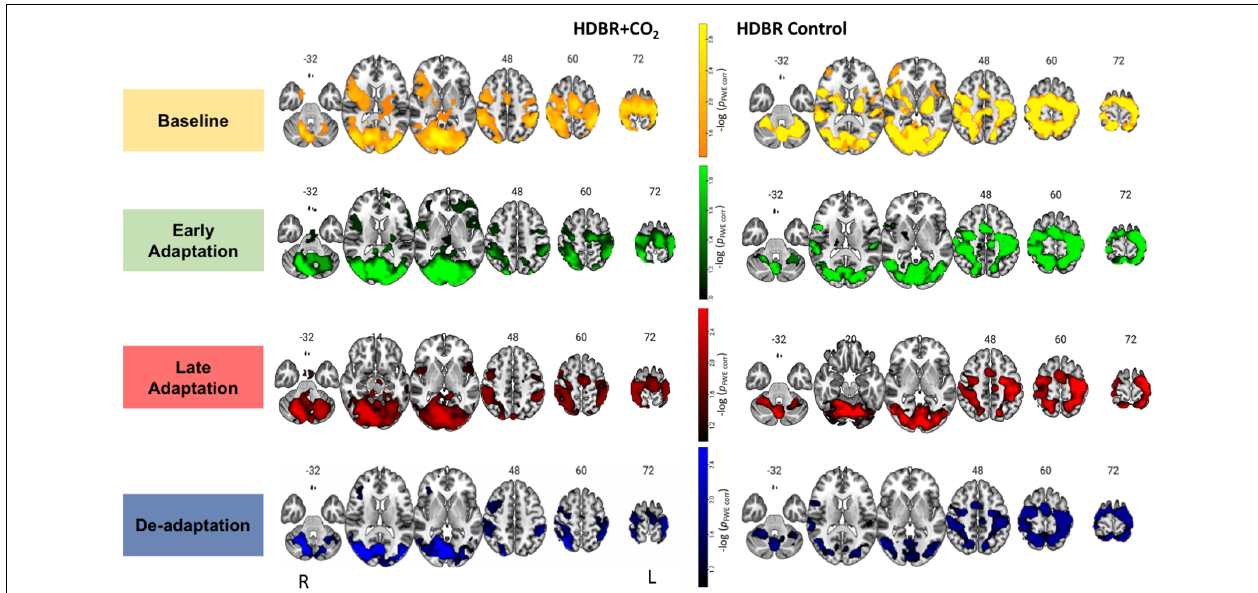
FIGURE 3 | Brain activation during each phase of visuomotor adaptation. Here we depict the main effect for each group HDBR+CO 2 (left) and HDBR Control (right) during each task phase: baseline (yellow-orange), early (green), late (red), and de-adaptation (blue). Whole brain results are overlaid onto an MNI standard template, thresholded at FWE < 0.10 and k = 10 voxels. The color scale depicts the -log( p FWE-corr ) values in which brighter colors (higher values) represent smaller p